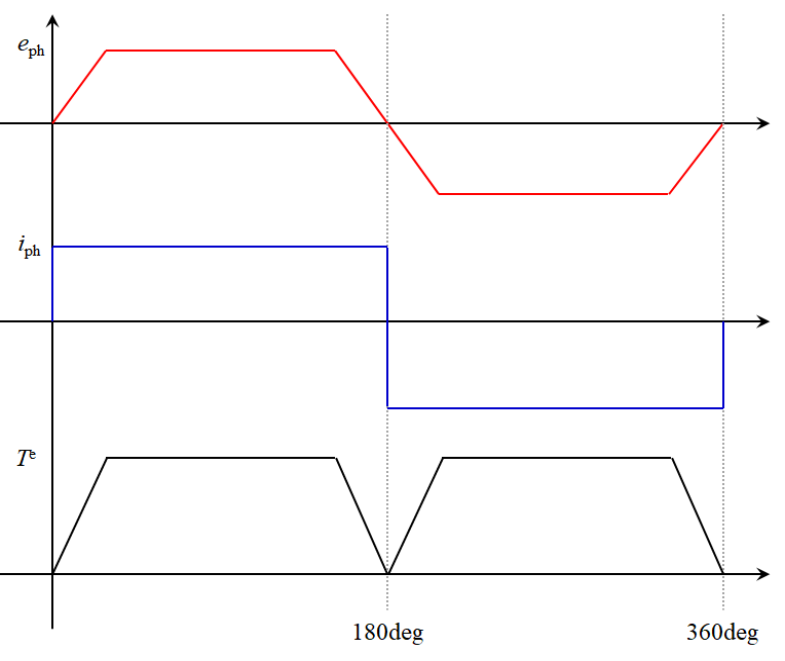
Figure 2. Relationship among the trapezoidal back-EMF, ideal direct current, and torque